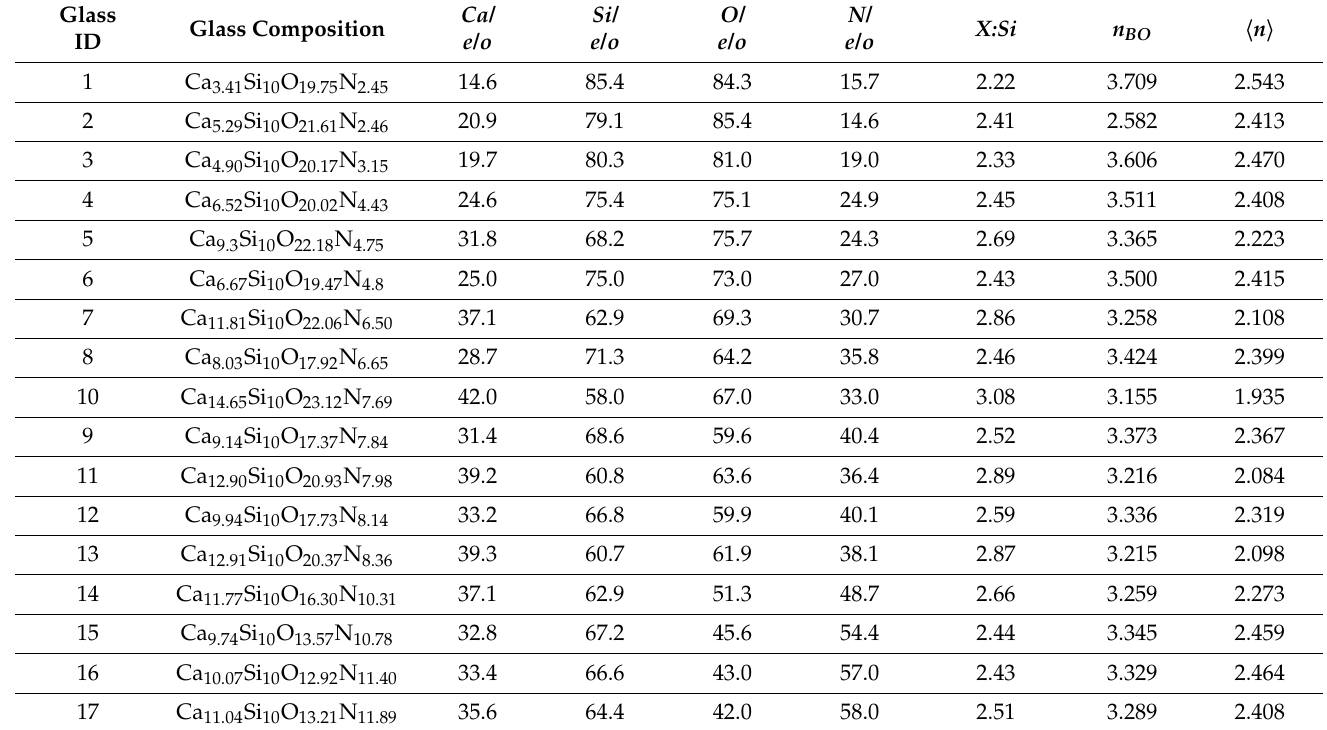
Table 1. Data for prepared Ca–Si–O–N glasses, determined glass composition, Ca content in e/o, Si content in e/o, O content in e/o, N content in e/o, X:Si ratio = [O,N]/[Si], number of bridging oxygen ( n BO ), and average coordination number